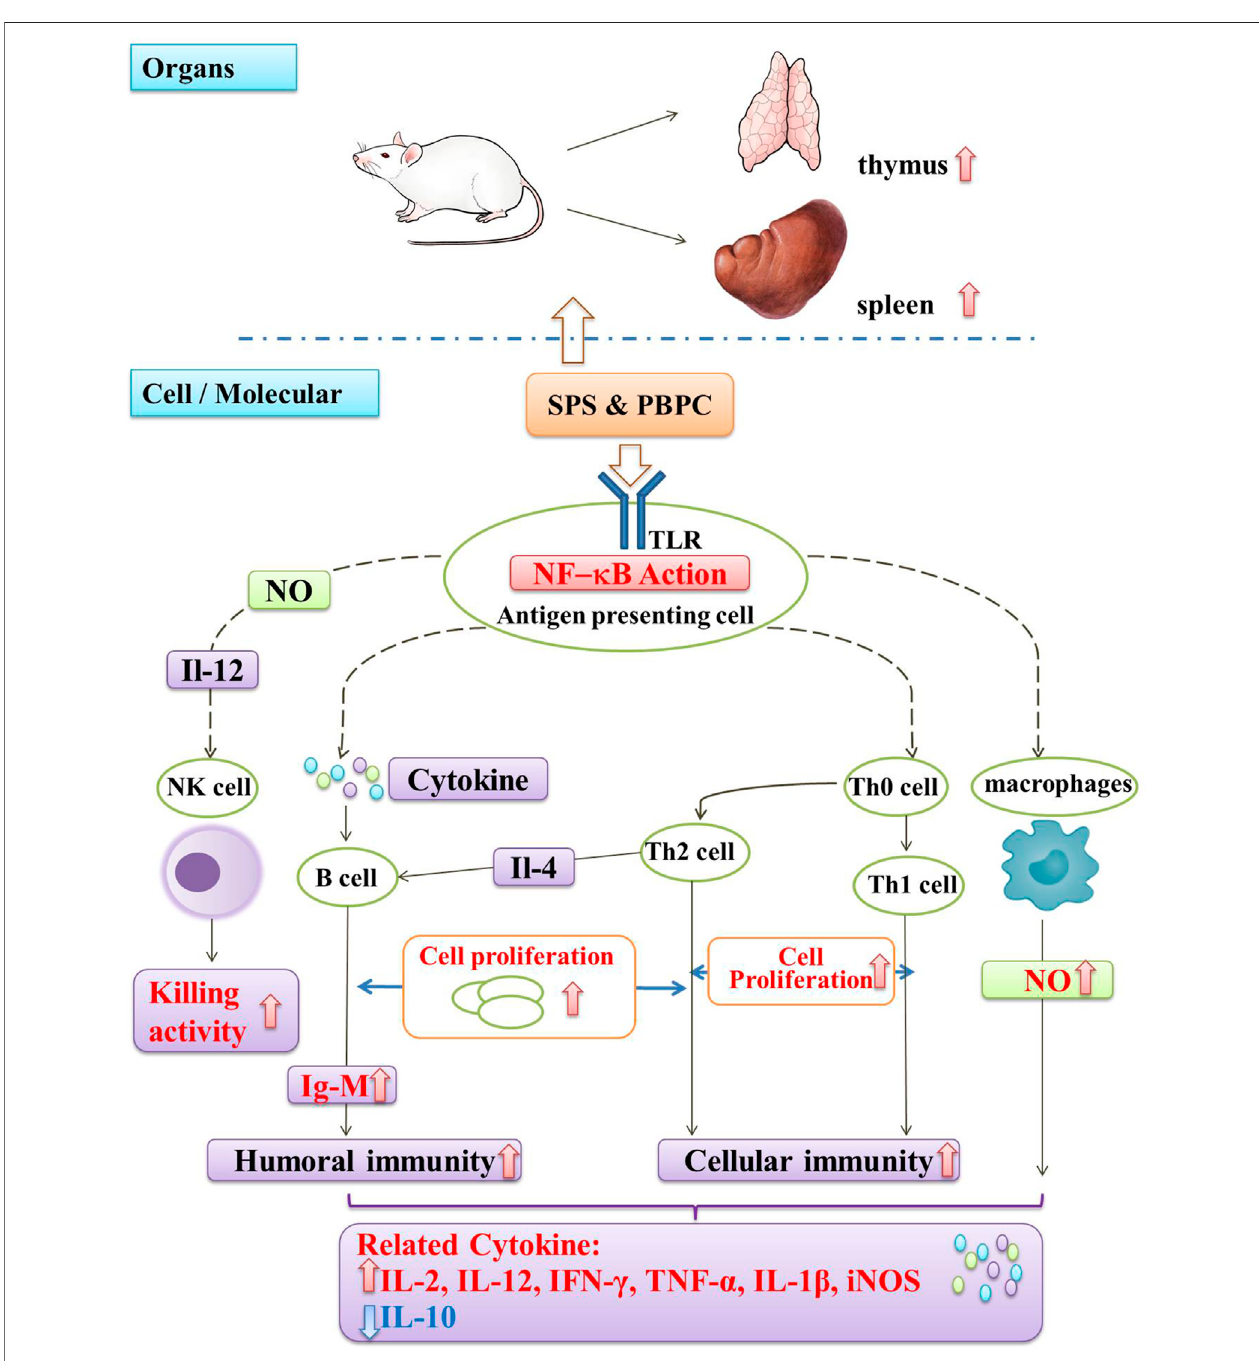
FIGURE 4 | Schematic diagram of immunomodulatory mechanism in SPS and PBPC (Red thick arrow: up-regulate; Blue thick arrow: down-regulate).